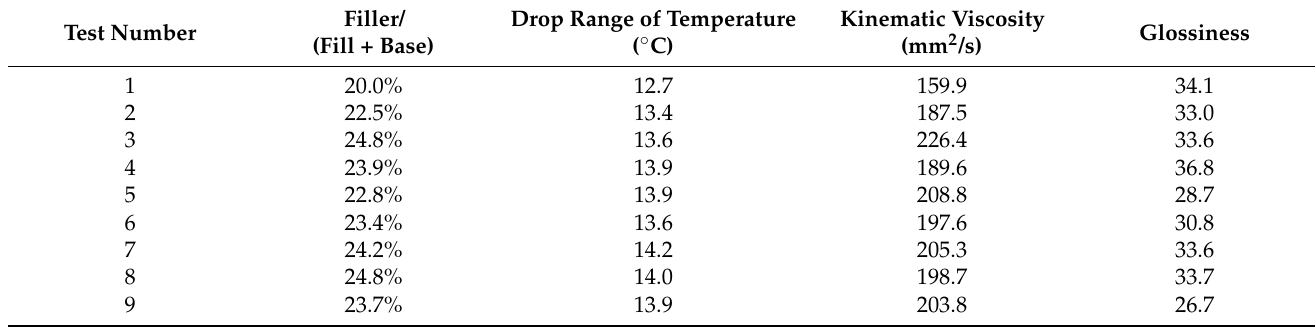
Table 6. Orthogonal test results of